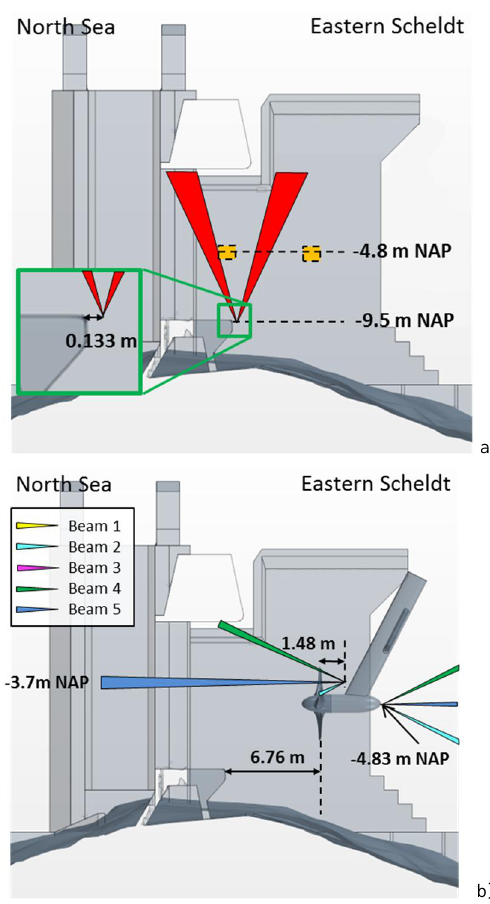
Fig. 3. Overview of the ADCP measurement: a) in 2011 without turbines and b) in 2015/2016 mounted from the turbines. Beams 1 and 3 are in the horizontal